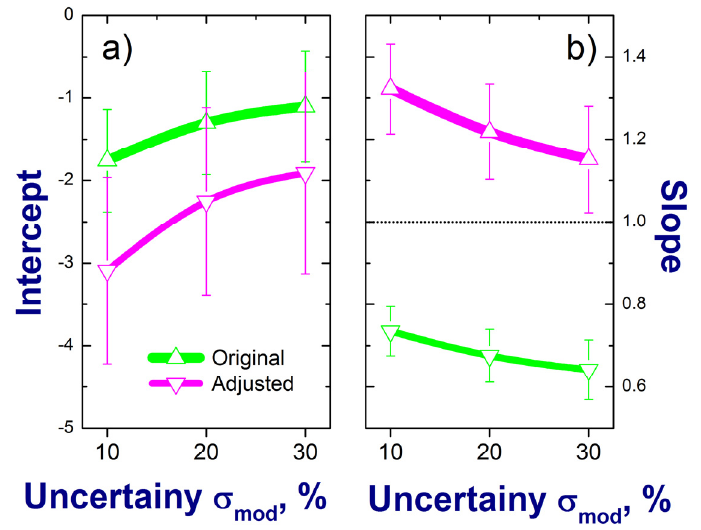
Figure 10. Intercept ( a ) and slope ( b ) of the linear regression fits (e.g., Figure 9) as a function of uncertainty for the ambient total scattering calculated for the original (without RI-based correction) and adjusted (with RI-based correction) size distributions. Error bars represent the standard errors of the displayed parameters (see text for